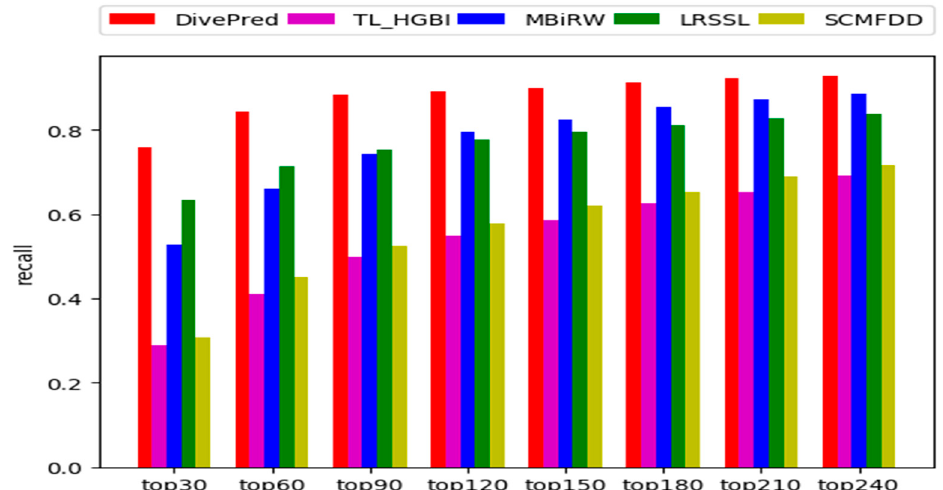
Figure 2. Average recall rates of all drugs at different top 𝑘 .